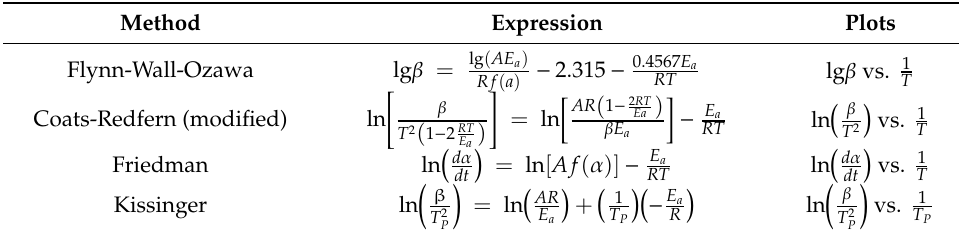
Table 2. Kinetic methods for activation energy assessment in the research [31]. Method Expression